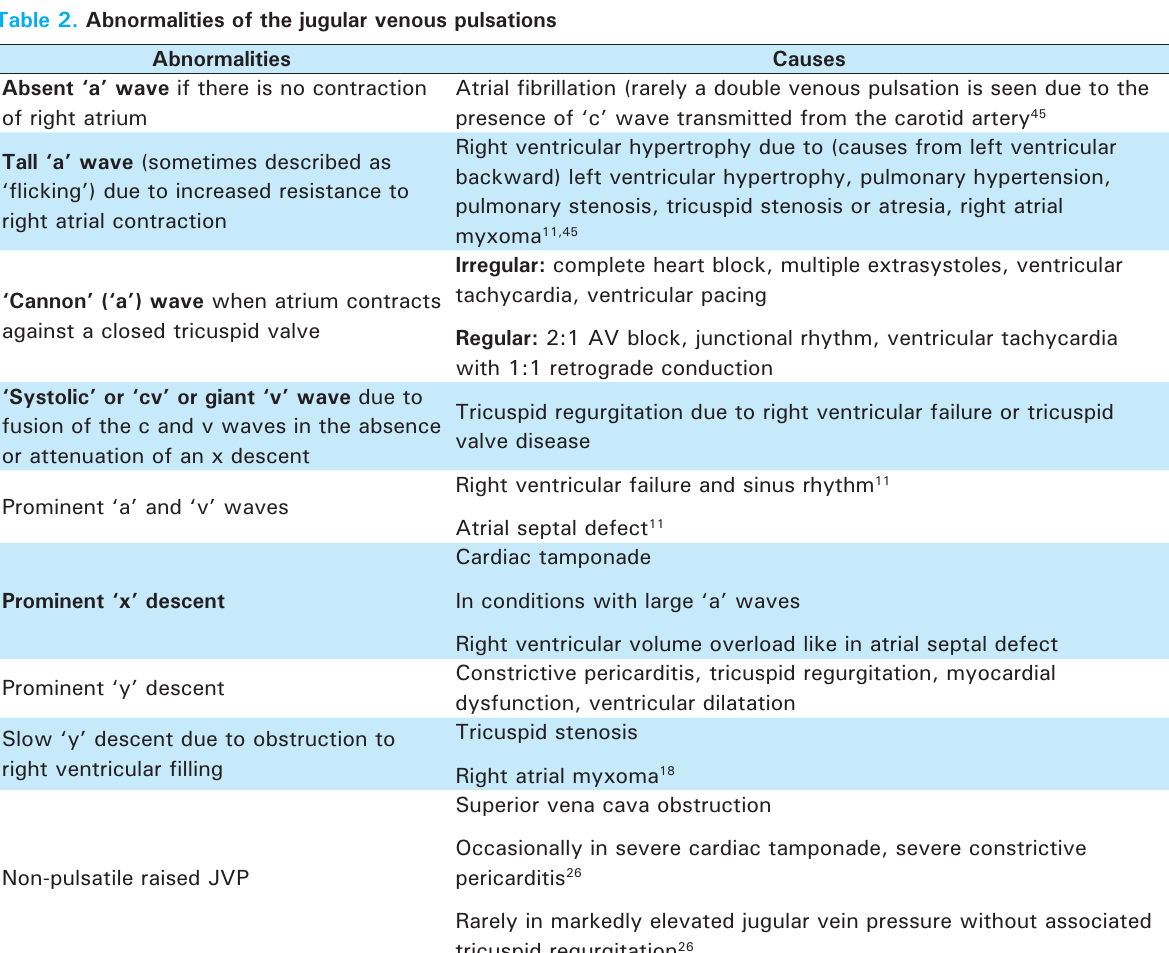
Table 2. Abnormalities of the jugular venous pulsations Abnormalities